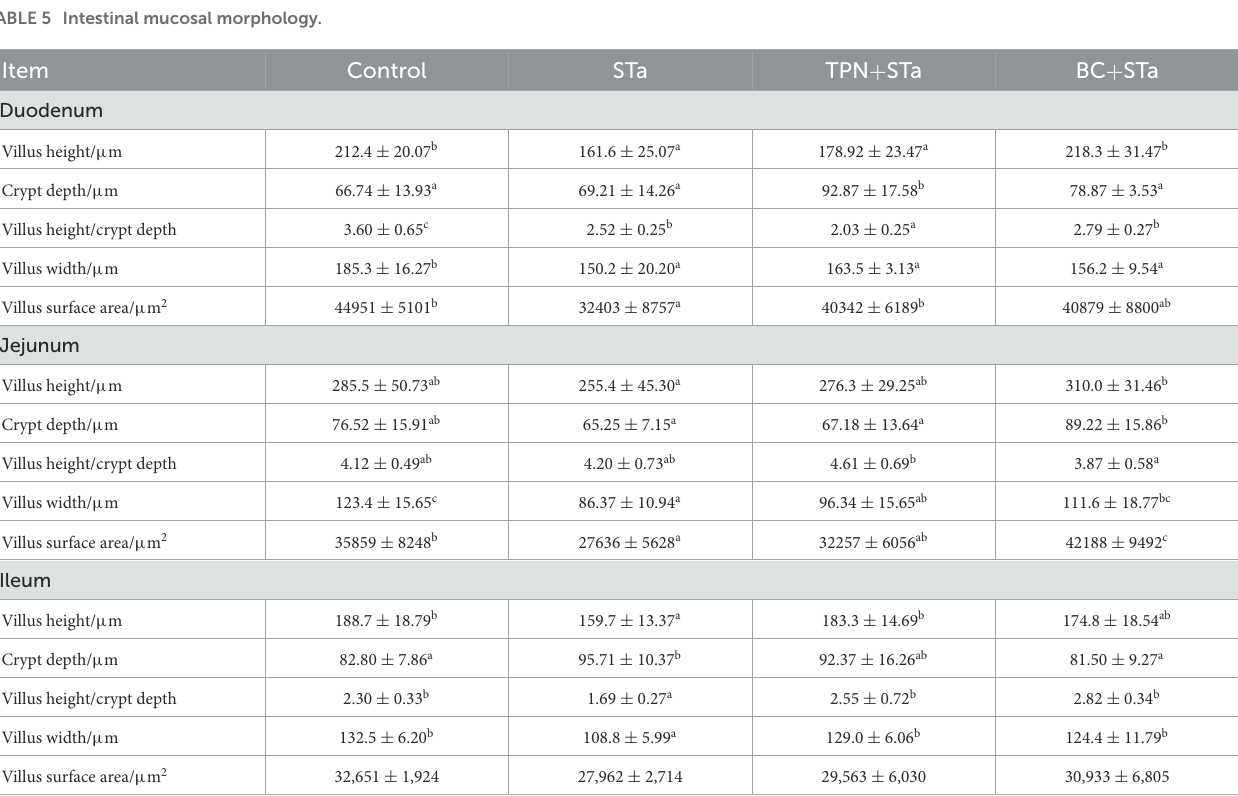
TABLE 5 Intestinal mucosal